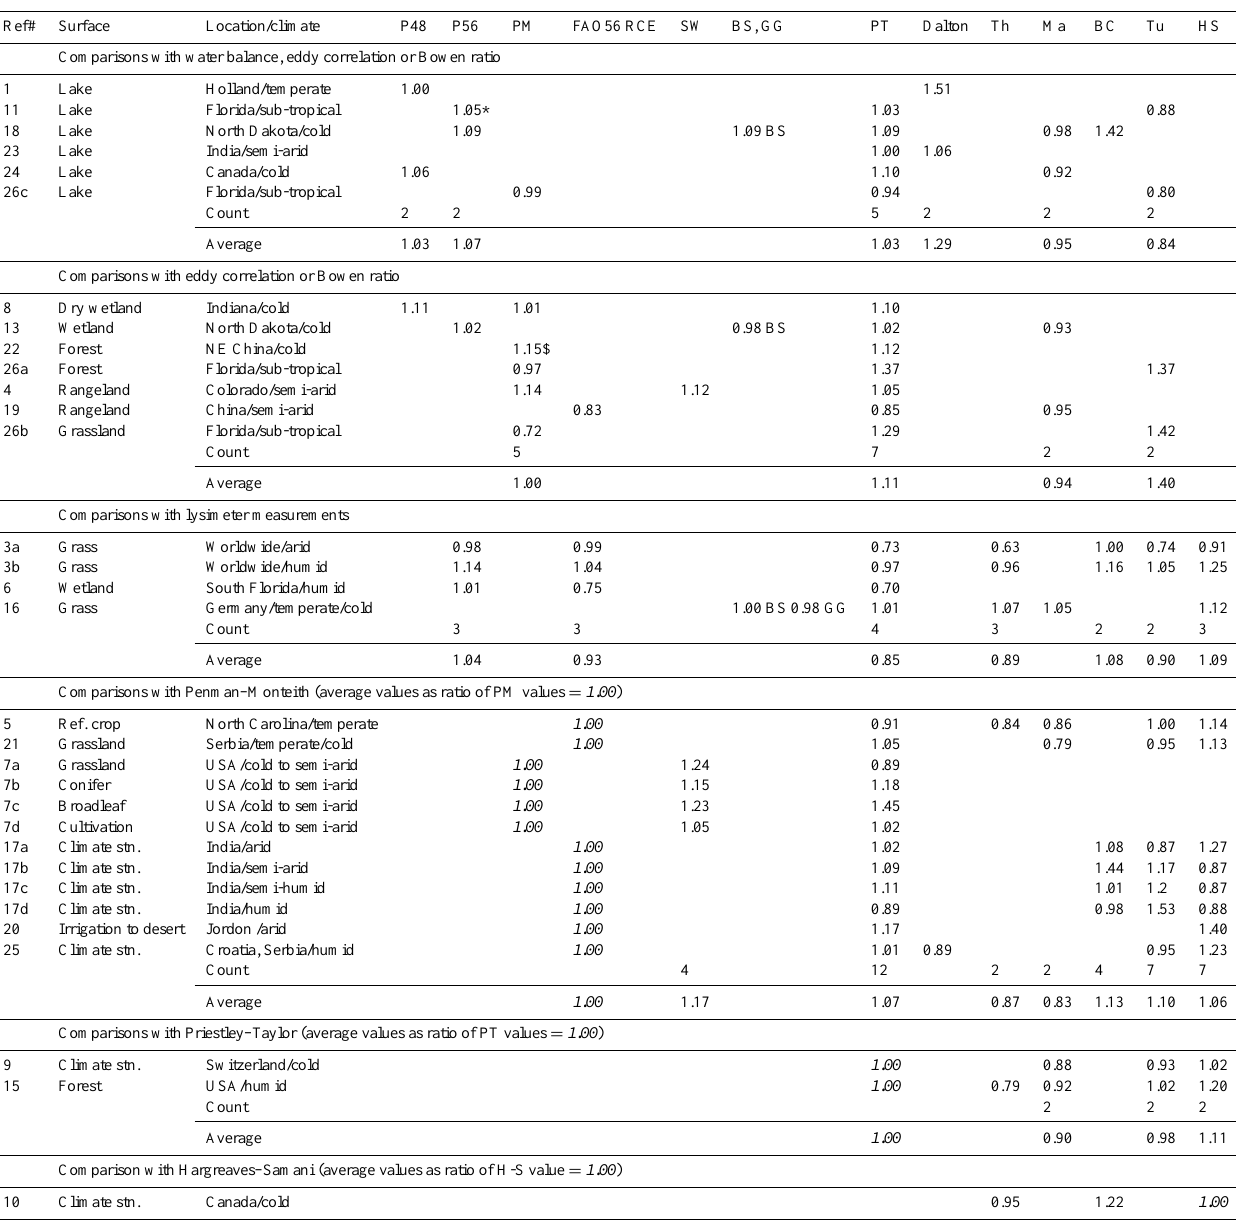
Table 6. Consolidated list of biases expressed as ratios of model estimations of actual and/or potential evaporation to field measurements, lysimeter observations or comparison with evaporation equations (P48: Penman, 1948; P56: Penman 1956; PM: Penman–Monteith; FAO56 RCE: FAO-56 reference crop evapotranspiration; SW: Shuttleworth–Wallace; BS, GG: Brutsaert–Strickler or Granger–Gray respectively; PT: Priestley–Taylor; Dalton: Dalton-type model; Th: Thornthwaite; Ma: Makkink; BC: Blaney–Criddle; Tu: Turc; HS: